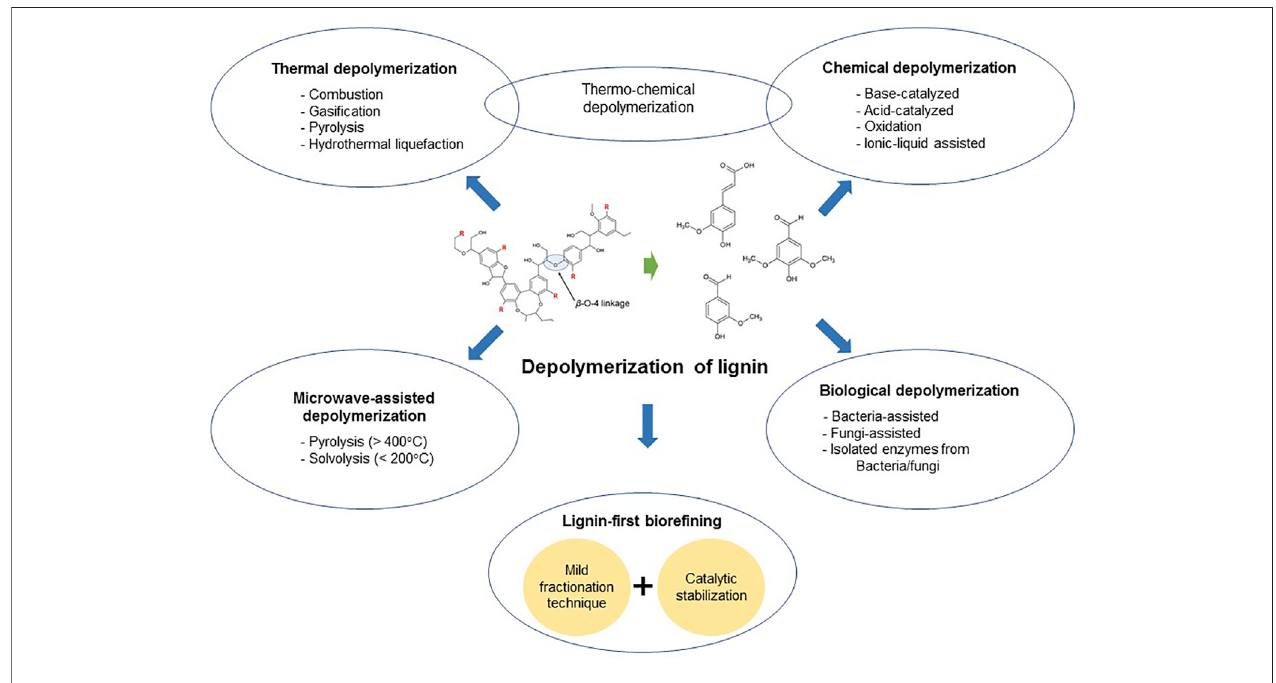
FIGURE 3 | Different technologies of lignin depolymerization.